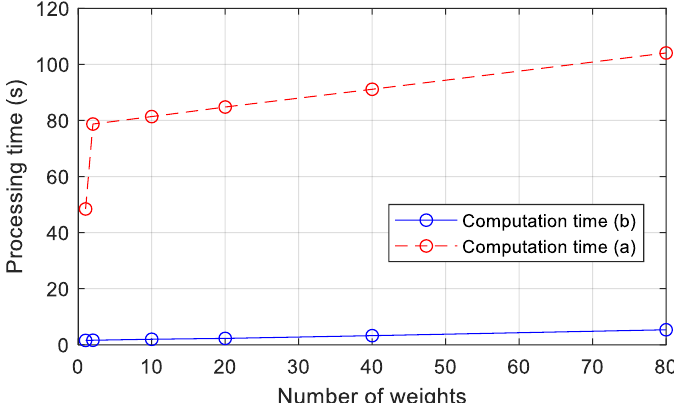
Figure 2. Processing time for number of weights.